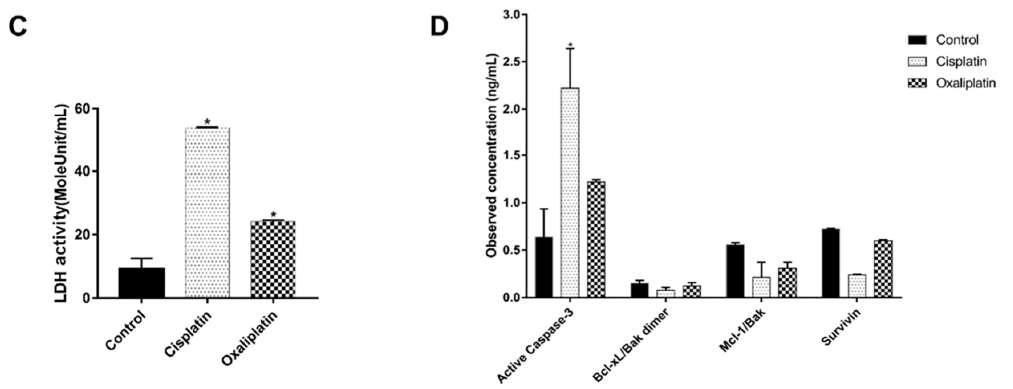
Figure 1. Cisplatin and oxaliplatin induced CCA cell toxicity. ( A ) KKU213L5 was incubated with chemo drugs as indicated concentrations and times. Cell viability as accessed by MTT method. ( B ) CCA cell was treated with drugs at IC50 concentration for 24 h before stained with annexin V/PI and analyzed by Muse analyzer. ( C ) Cell conditioned media were collected and measured LDH activity. ( D ) Treated cells were lysed and harvested intracellular protein for measure apoptotic marker by Bio-Plex Pro RBM Apoptosis Assays panel 3. * p < 0.05.